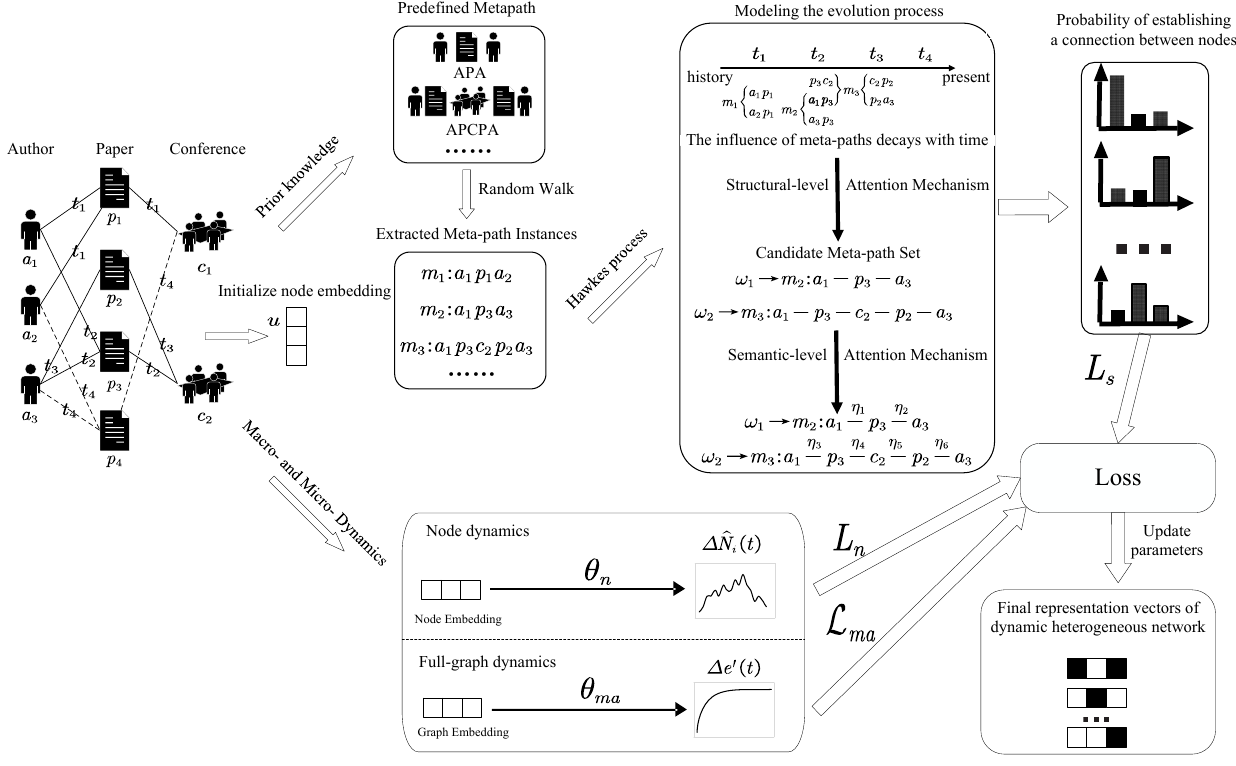
Figure 1. The overall framework of the